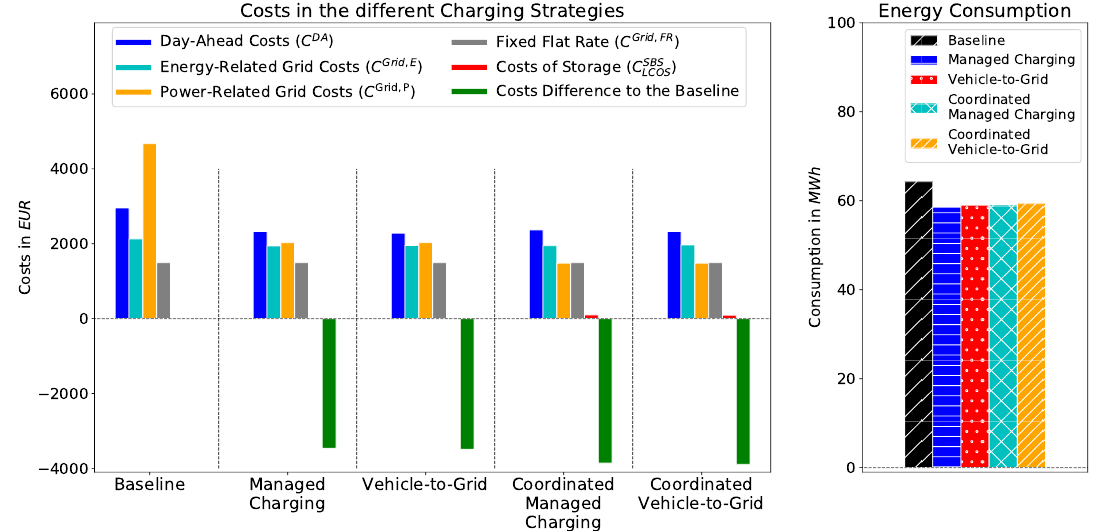
Figure 5. Costs and energy consumption in the different charging